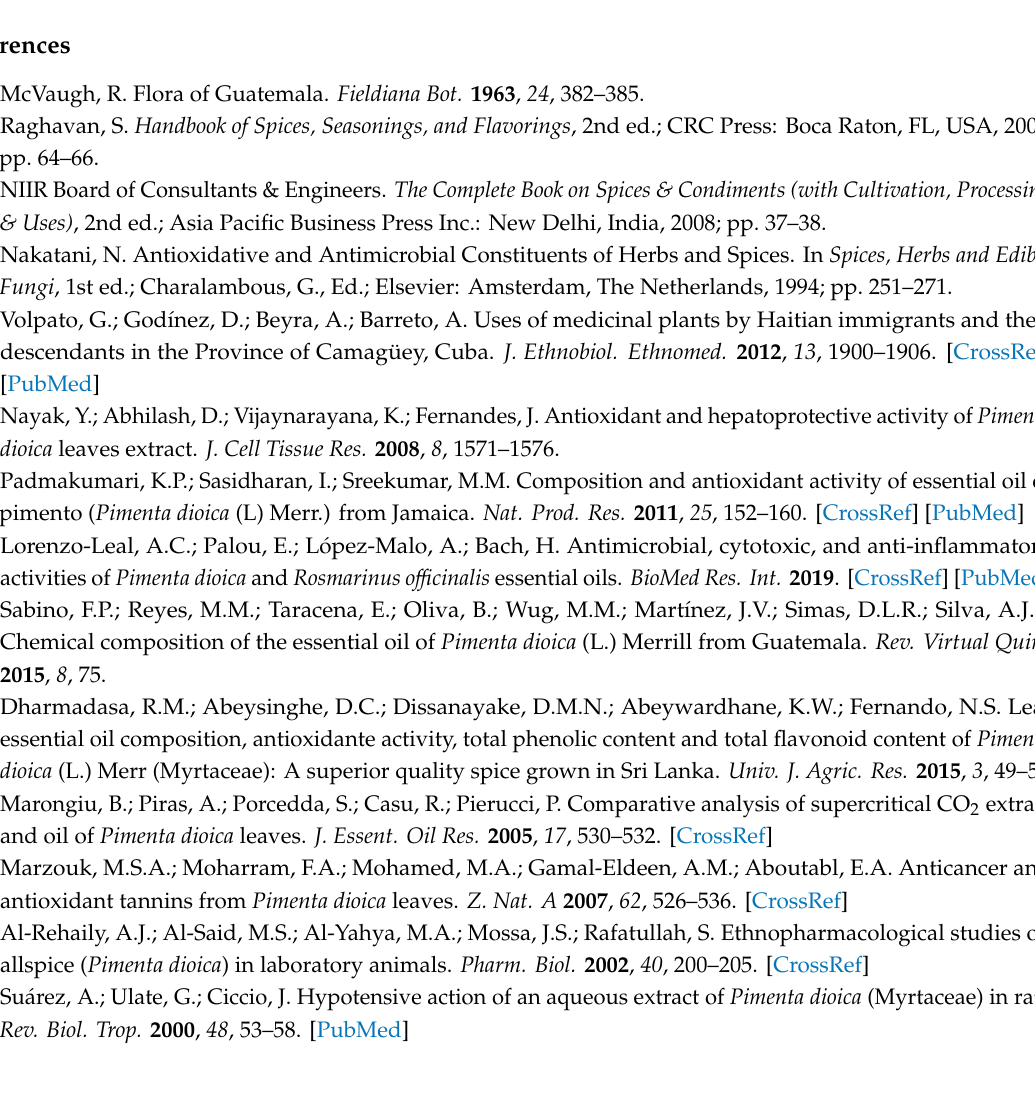
Figure S1: Gas chromatography coupled to mass spectrometry analysis (GC / MS) chromatogram of the essential oil of leaves of P. dioica ; Figure S2: Report of the chromatographic results of GC / MS analysis of the essential oil of leaves of P. dioica ; Figure S3: Continuation of report of the chromatographic results of GC / MS analysis of the essential oil of leaves of P. dioica ; Figure S4: GC / MS chromatogram of the essential oil of leaves of P. dioica ; Figure S5: Report of the chromatographic results of GC / MS analysis of the essential oil of fruits of P. dioica ; Figure S6: Continuation of report of the chromatographic results of GC / MS analysis of the essential oil of fruits of P. dioica